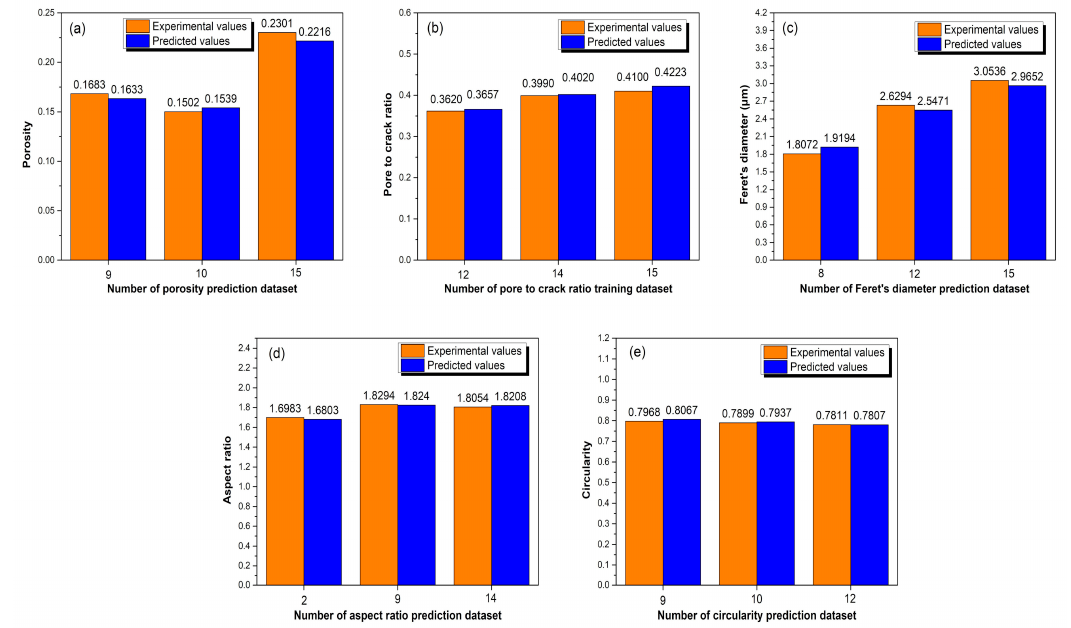
Figure 4. The testing results and the prediction results of the microstructural features of the CS-SVM prediction model. ( a ) Porosity; ( b ) pore-to-crack ratio; ( c ) maximum Feret’s diameter; ( d ) aspect ratio; ( e ) circularity.